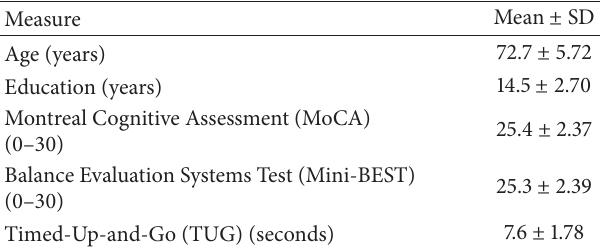
Table 1: Sample characteristics ( 𝑁 = 32